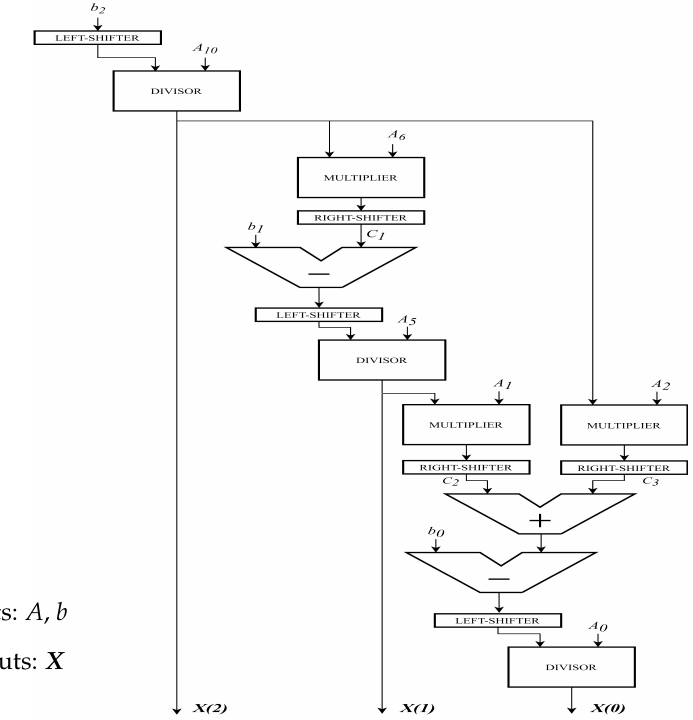
Figure 5. Back-Substitution and Storing